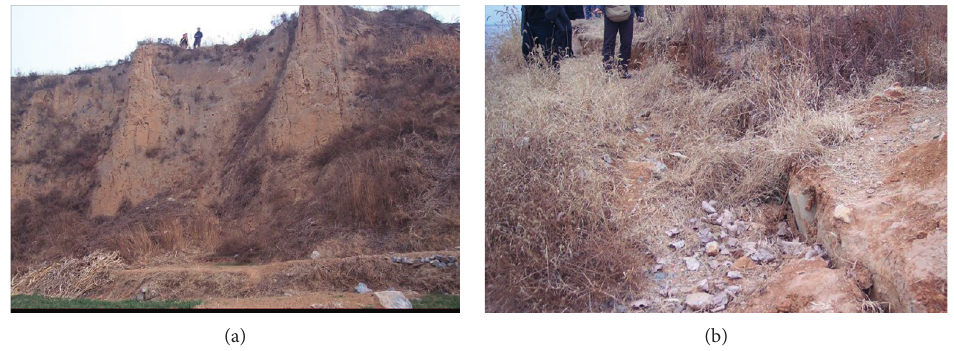
Figure 1: Actual geological site. (a) Terrain. (b) Longitudinal crack at the top of